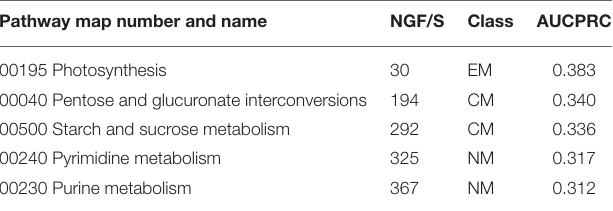
TABLE 5 | Clus-HMC random forest prediction results of metabolic pathway map based on phylogenetic profile of gene families and singleton genes. Pathway map number and name